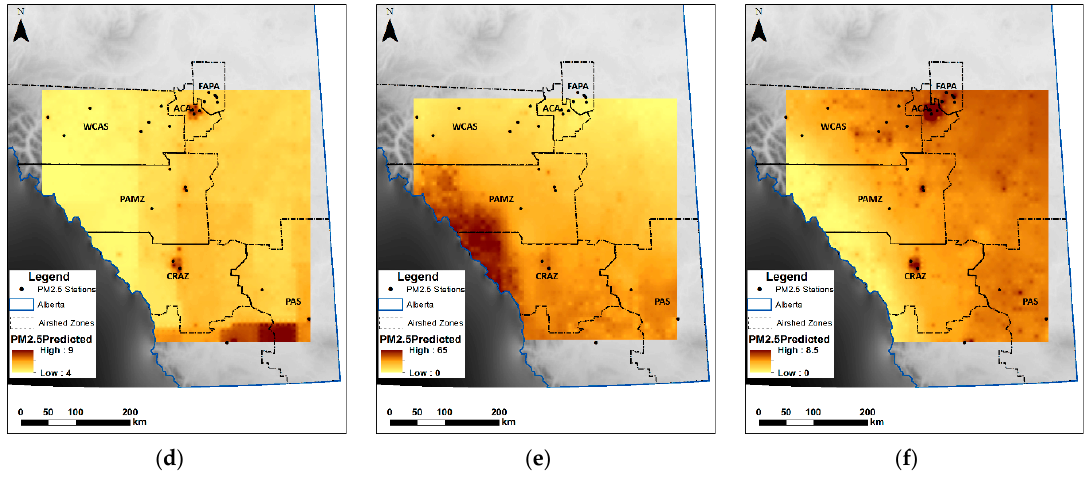
Figure 3. The predicted PM 2.5 maps over the study area including: Prediction results obtained by models’ coefficient at grid centroid ( a – c ), and interpolated maps between grids ( d – f ), for the three periods separately: ( a , d ) Pre-fire predicted maps, ( b , e ) during-fire predicted maps, and ( c , f ) post-fire predicted maps.